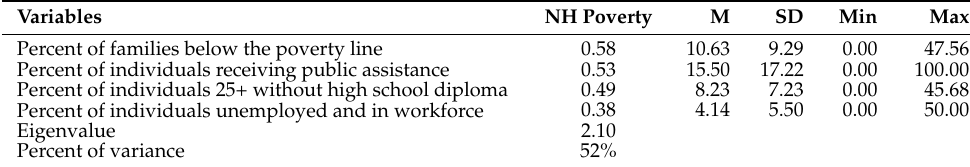
Table 2. Principal component analysis for census-based measures by ZIP code tabulation